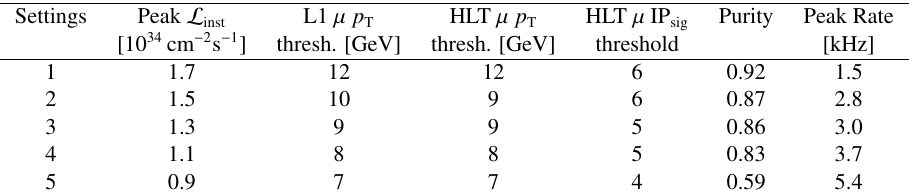
Table 1. Summary of the tag-side muon trigger requirements imposed by the L1 and HLT algorithms: the L1 and HLT muon p T thresholds, and the HLT muon impact parameter significance IP sig . Also shown are the trigger purity and peak trigger rate. All values are shown as a function of the peak L inst . Table contents taken from Ref.